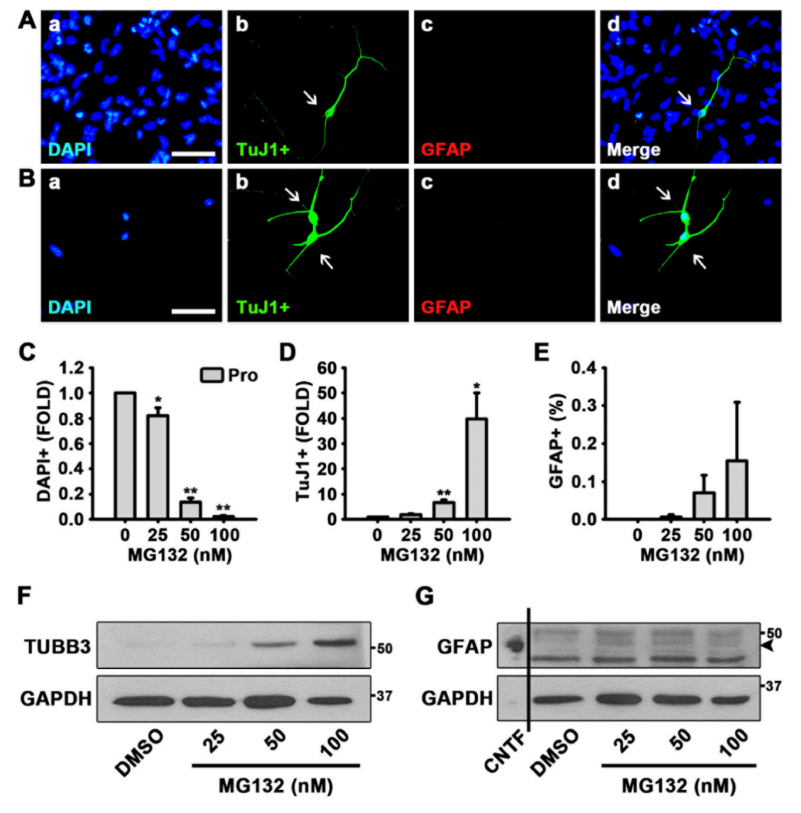
Figure 1. MG132 increases the percentage of neurons in the presence of growth factors in neural stem cells (NSCs). ( A , B ) Representative immunofluorescence images of NSCs proliferated for 48 h [4 (cid:48) ,6-diamidino-2-phenylindole (DAPI)-positive nuclei ( a , blue), TuJ1-positive neurons ( b , green), glial fibrillary acidic protein (GFAP)-positive astrocytes ( c , red), and merged image ( d )]. Scale bar = 50 µ m. NSCs were treated with ( A ) dimethyl sulfoxide (DMSO) or ( B ) 100 nM MG132 in the presence of growth factors. ( C – E ) Quantification of ( C ) nuclei, ( D ) neurons, and ( E ) astrocytes. Data are expressed as mean ± standard error of mean (SEM) ( n = 3). ( F , G ) Representative images of the protein bands of ( F ) β III Tubulin (TUBB3) and ( G ) GFAP. Two days after treatment, total cell lysates from proliferated NSCs were subjected to western blotting analysis with TuJ1 and GFAP antibodies. Glyceraldehyde 3-phosphate dehydrogenase (GAPDH) was used as a loading control, and ciliary neurotrophic factor (CNTF) was used as a positive control for GFAP. * p < 0.05, and ** p < 0.01 (Student’s t